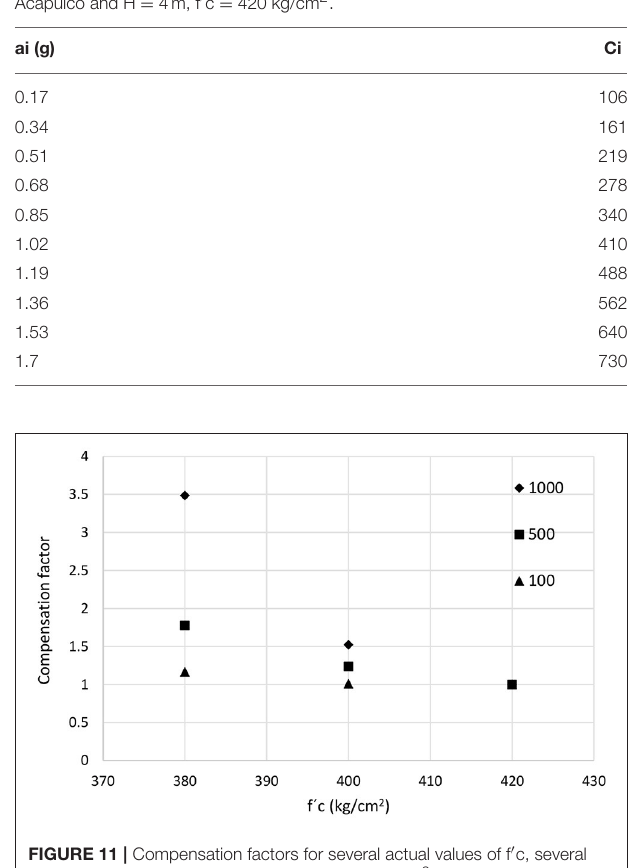
FIGURE 10 | Mass probability distribution of ground acceleration for Acapulco.